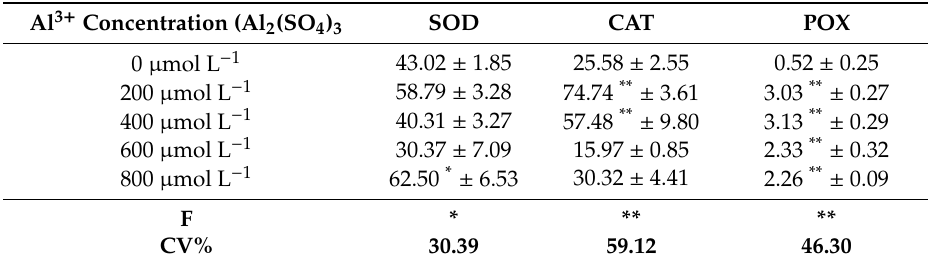
Table 4. Antioxidant Eugenia dysenterica root system superoxide dismutase (SOD), catalase (CAT), peroxidase (POX) enzyme activities after 20 days of growth in a hydroponic culture at di ff erent Al concentrations (0, 200, 400, 600 and 800 µ mol L − 1 ).